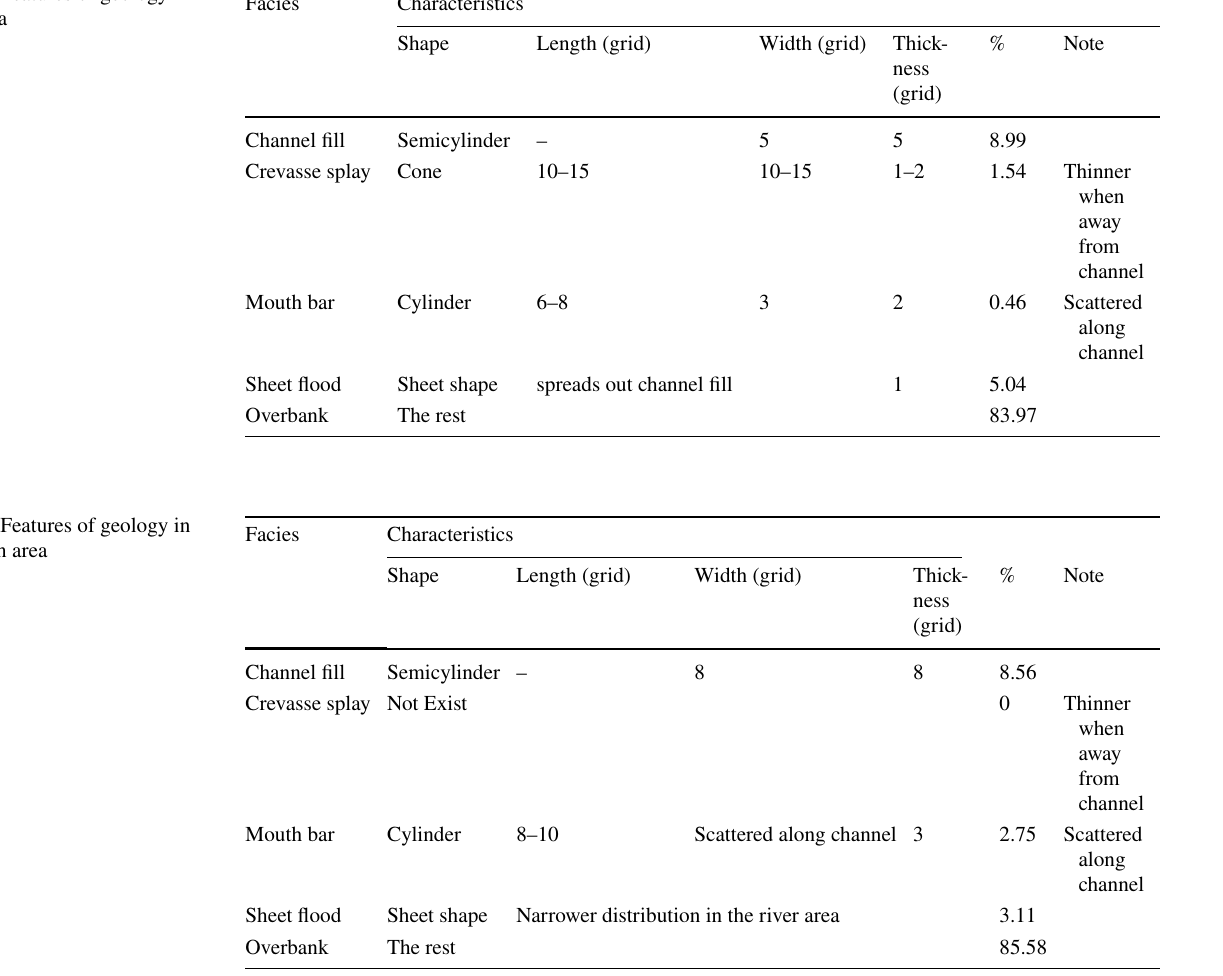
Table 1 Features of geology in